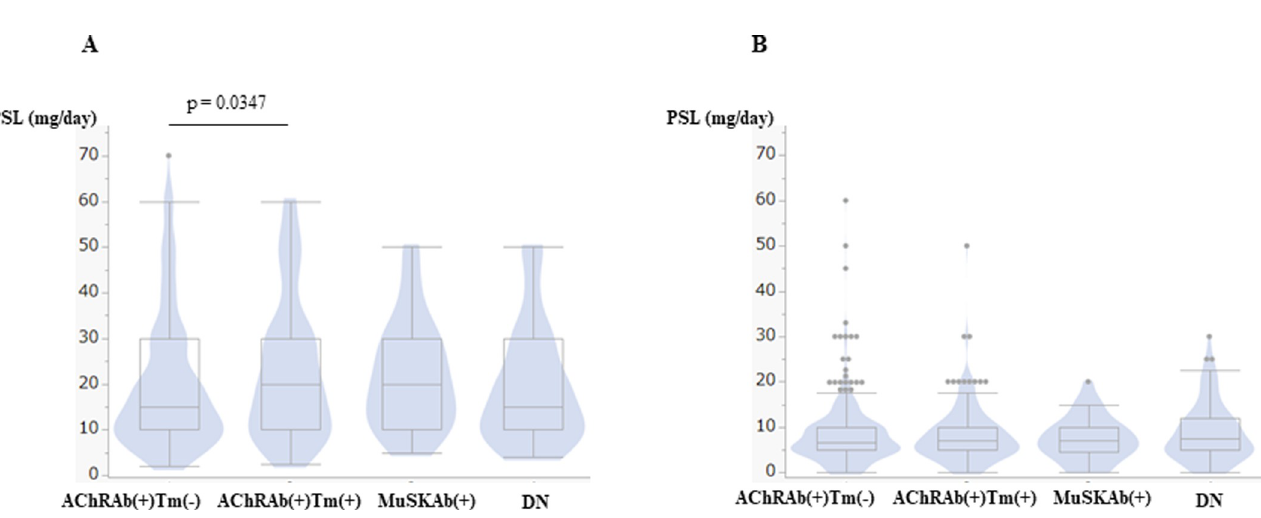
Fig 7. Prednisolone (PSL) dose at the maximum and the current states. (A) Box and violin plot plots of prednisolone (PSL) at maximum dose. (B) Box and violin plot of PSL at the current dose. The horizontal line within the box represents the median value. The box ends represent the 25th and 75th quantiles, expressed as the first and third quartiles. The lines that extend from the box end are whiskers. The whiskers extend from the ends of the box to the outermost data point that falls within these distances. 1st quartile–1.5 x (interquartile range), 3rd quartile+1.5 x (interquartile range). For statistical analysis, Steel-Dwass All Pairwise Comparison was